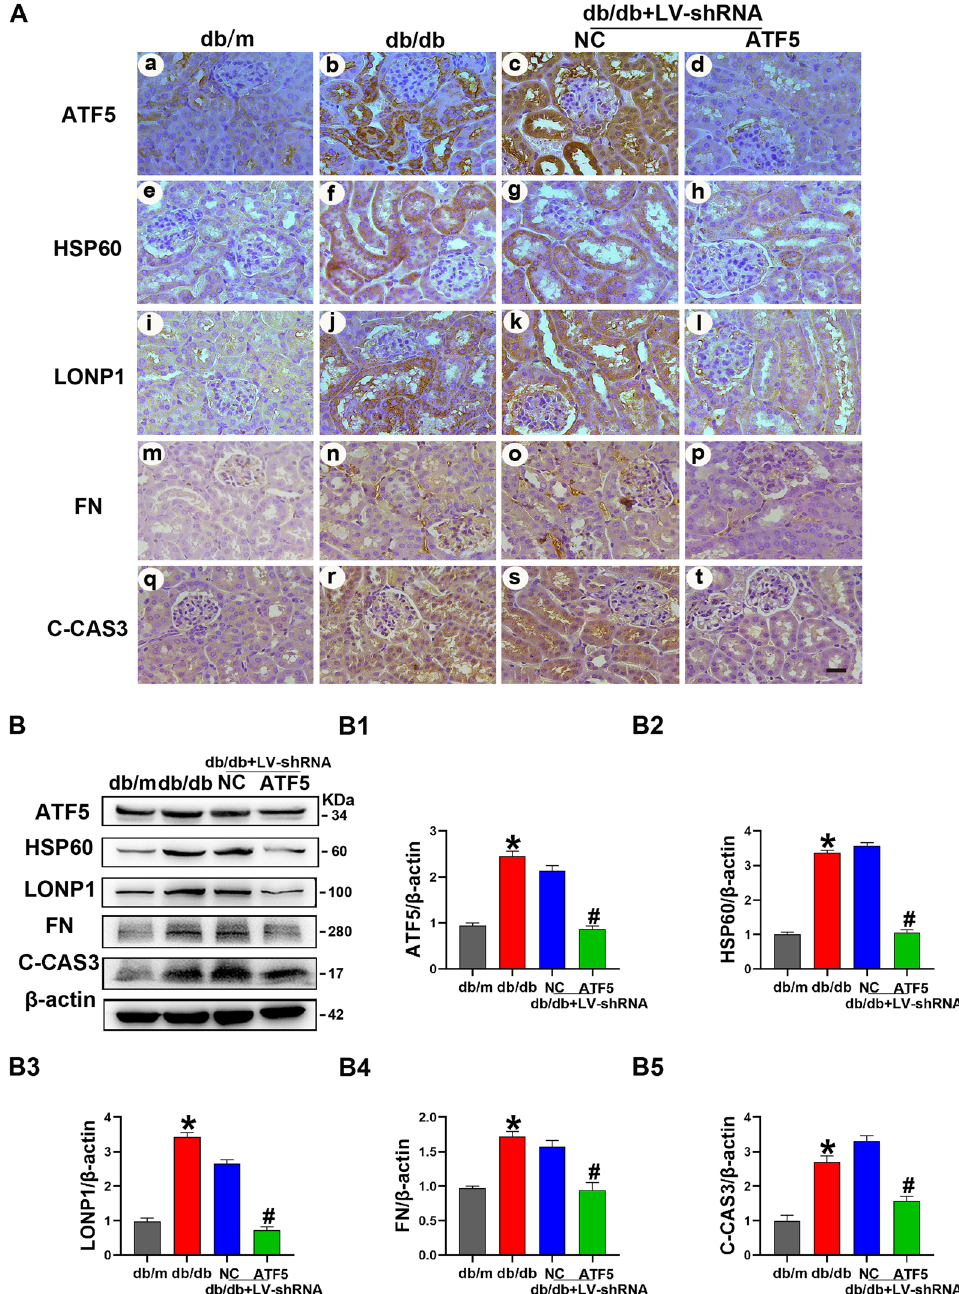
Fig. 4 Upregulated expression of ATF5/HSP60/LONP1, FN/C-CAS3 in the kidney sections of db/db mice was attenuated by injection of ATF5 LV-shRNA. A Representative IHC images of ATF5, HSP60, LONP1, FN, C-CAS3 in the kidneys of mice. Scale bar: 30 μm. B Western blot analysis of ATF5, HSP60, LONP1, FN, C-CAS3. B1–B5 Relative band density of ATF5, HSP60, LONP1, FN, C-CAS3. All data are presented as means db/m; # p < 0.05 vs. db/db LV-NC-shRNA. n + =